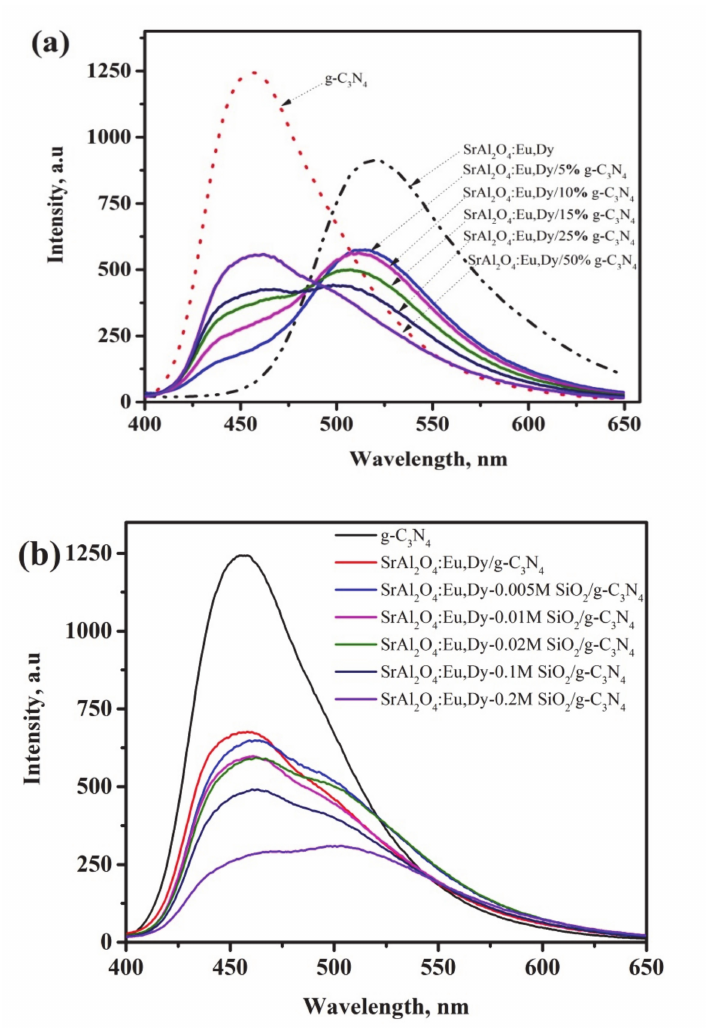
Figure 6. Photoluminescence spectra for ( a ) the SrAl 2 O 4 :Eu,Dy / g-C 3 N 4 and ( b ) for SrAl 2 O 4 :Eu,Dy / 50 wt.% g-C 3 N 4 with varying SiO 2 -binder